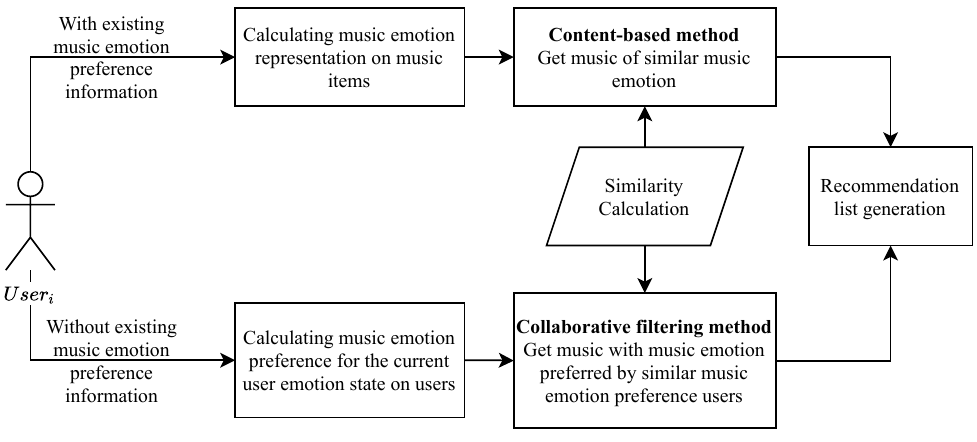
Figure 6. The recommendation process of